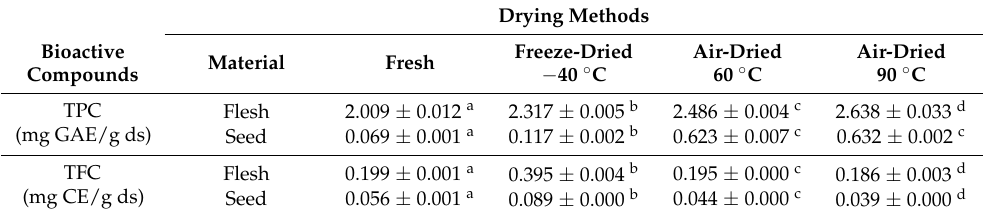
Table 3. Total polyphenol and total flavonoid content of wild blueberries ( Sideroxylon mascatense